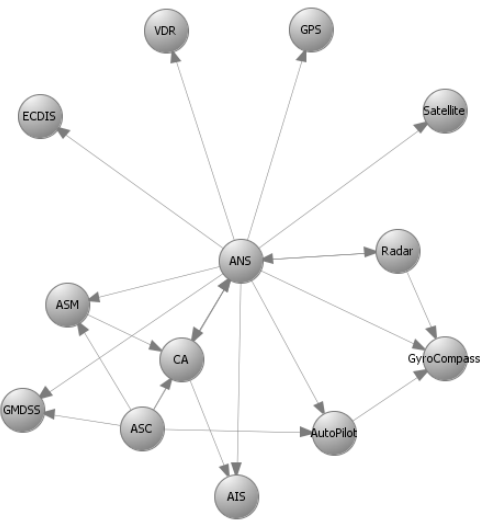
Figure 4. Autonomous ship—Navigational CPSs– G C ( V , E ) –Control flow